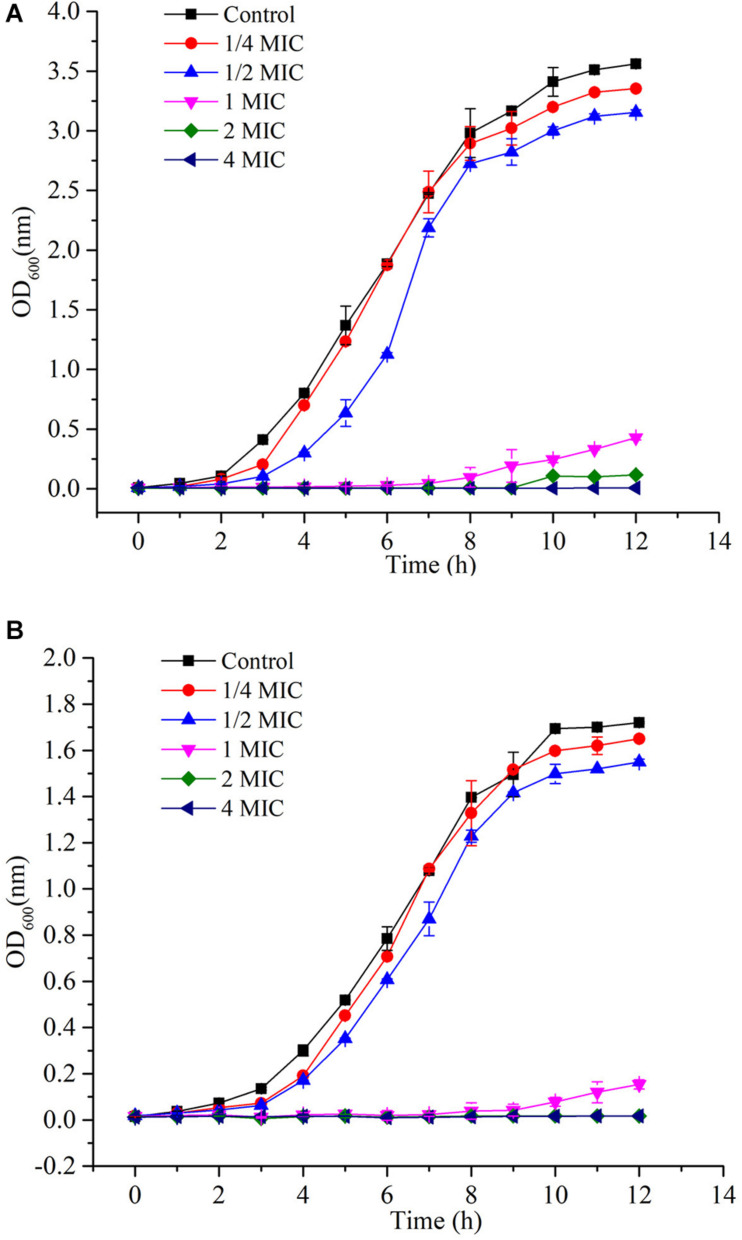
Growth curves (A)
L. monocytogenes and (B)
V. parahemolyticus.